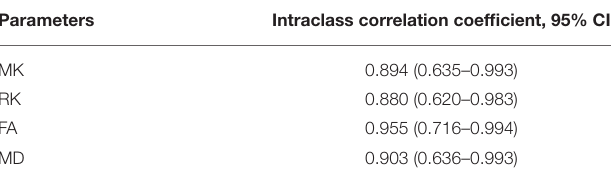
TABLE 2 | Inter-observer consistency of measurements.